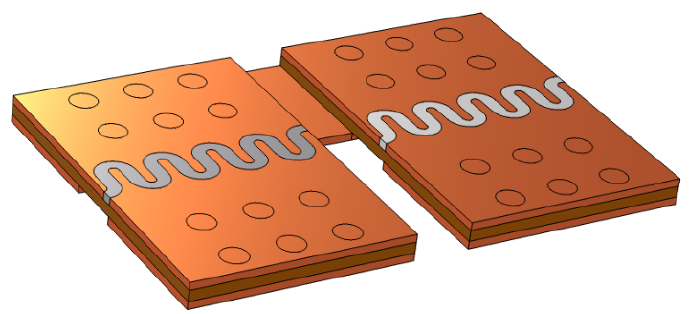
Figure 2. New design of the μ‐ TEG with a sinusoidal trench.